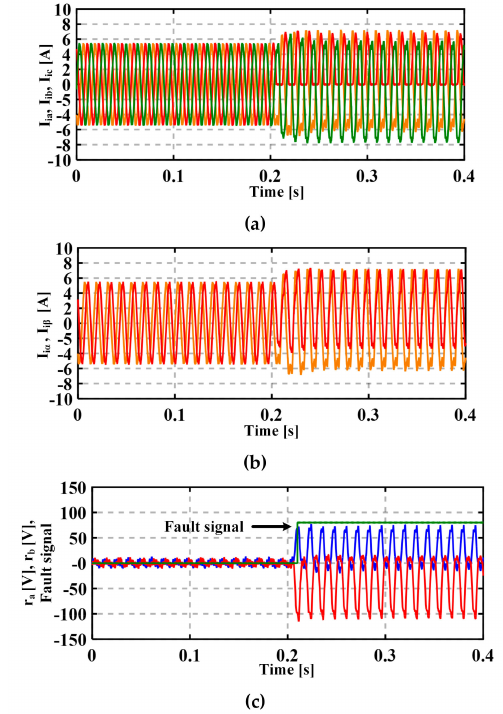
Figure 11. Experimental results: Open-switch fault on Q 4 at 0.2 s. ( a ) Filter currents of the three phases I ia (yellow), I ib (red), I ic (green); ( b ) filter currents in the stationary reference frame i i α (yellow), i i β (red); ( c ) residual errors r α (blue) r β (red), and fault signal